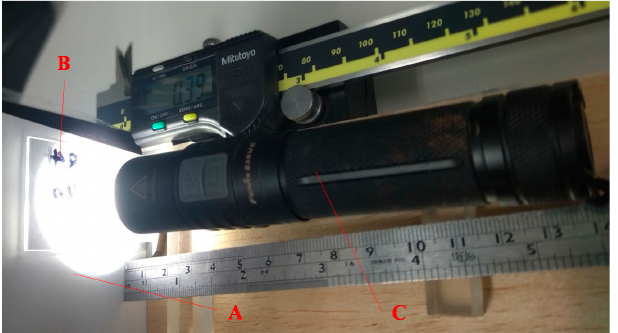
Figure 11. Focal length measurement of the microlens, where A is the screen, B is the microlenses, and C is the light respectively.